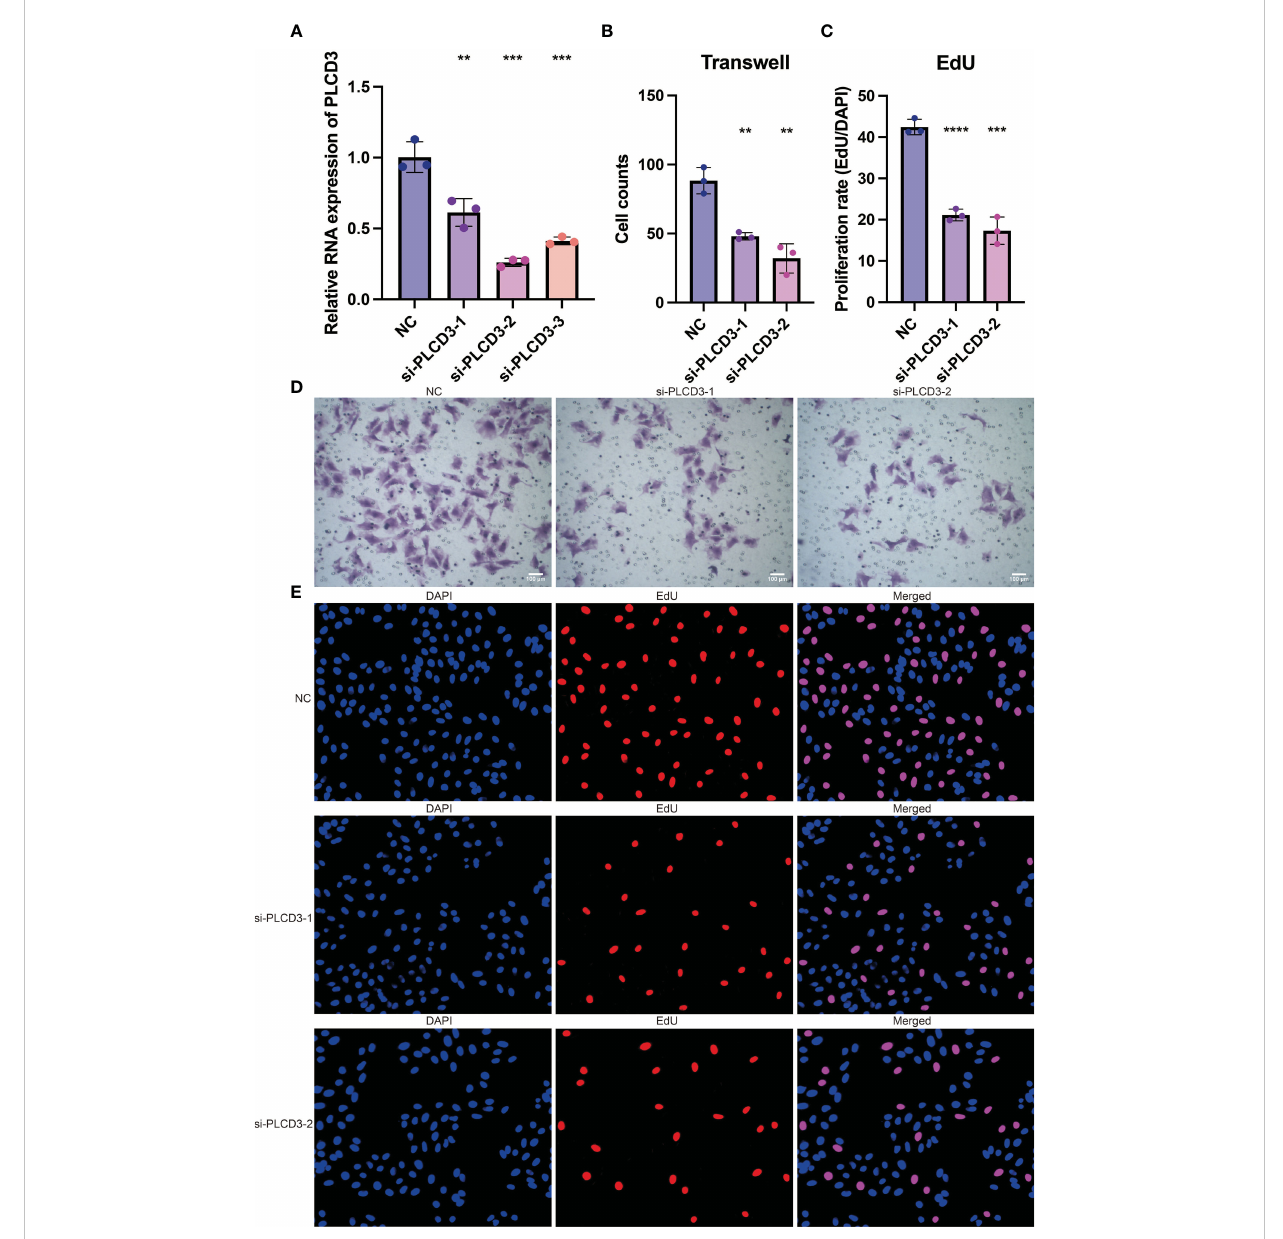
FIGURE 8 The tumor-promoting role of PLCD3. (A) The relative RNA expression of PLCD3 in NC and three si-RNA groups by q-PCR assay. (B) Statistical analysis of the cell counts in NC and two si-RNA groups by Transwell assay. (C) Statistical analysis of the proliferation rate (EdU/DAPI) in NC and two si-RNA groups by EdU assay. (D) The cell counts in NC and two si-RNA groups by Transwell assay. (E) The proliferation rate (EdU/DAPI) in NC and two si-RNA groups by EdU assay. **, P<0.01; ***, P<0.001; ****,